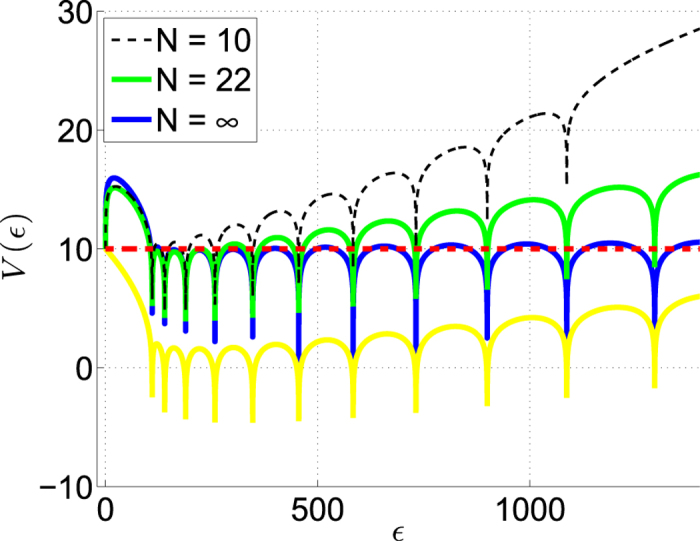
Graphical illustration of the the characteristic equation for a ring with a weak link.The red line is V(0). The blue line is V() as deduced from the LHS of equation (25) with L = 1, and g = 10−3 and . The yellow line is an attempted reconstruction of V() from the first N = 22 roots k of the  equation. The green line is a proper reconstruction that takes into account an impurity term 0. The deviation from the blue line for large k is due to finite truncation: compare the N = 10 line with the N = 22 line.